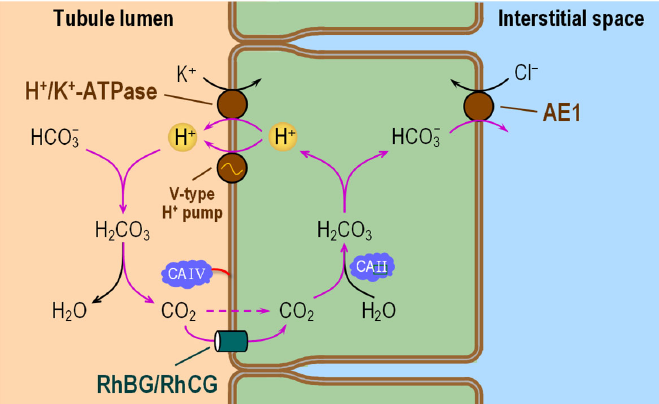
Figure 8. Cell model of HCO 3 − reabsorption in α -intercalated cells of the distal nephron. In the lumen, residual filtered HCO 3 − and H + —secreted by H + /K + -pump and V-type H + pump—react to form CO 2 and H 2 O under the catalytic action of CA IV. Apical entry of CO 2 via RhBG/RhCG leads to the intracellular formation of HCO 3 − and H + under the catalytic action of CA II. AE1 carries HCO 3 − out of the cell across the basolateral membrane. V ‐ type H + pump = Vacuolar ‐ type H + pump (or V ‐ ATPase); RhBG/RhCG = Rh family B glycoprotein/Rh family C glycoprotein; CA II and CA IV= carbonic anhydrase II and IV; AE1 = anion exchanger 1.